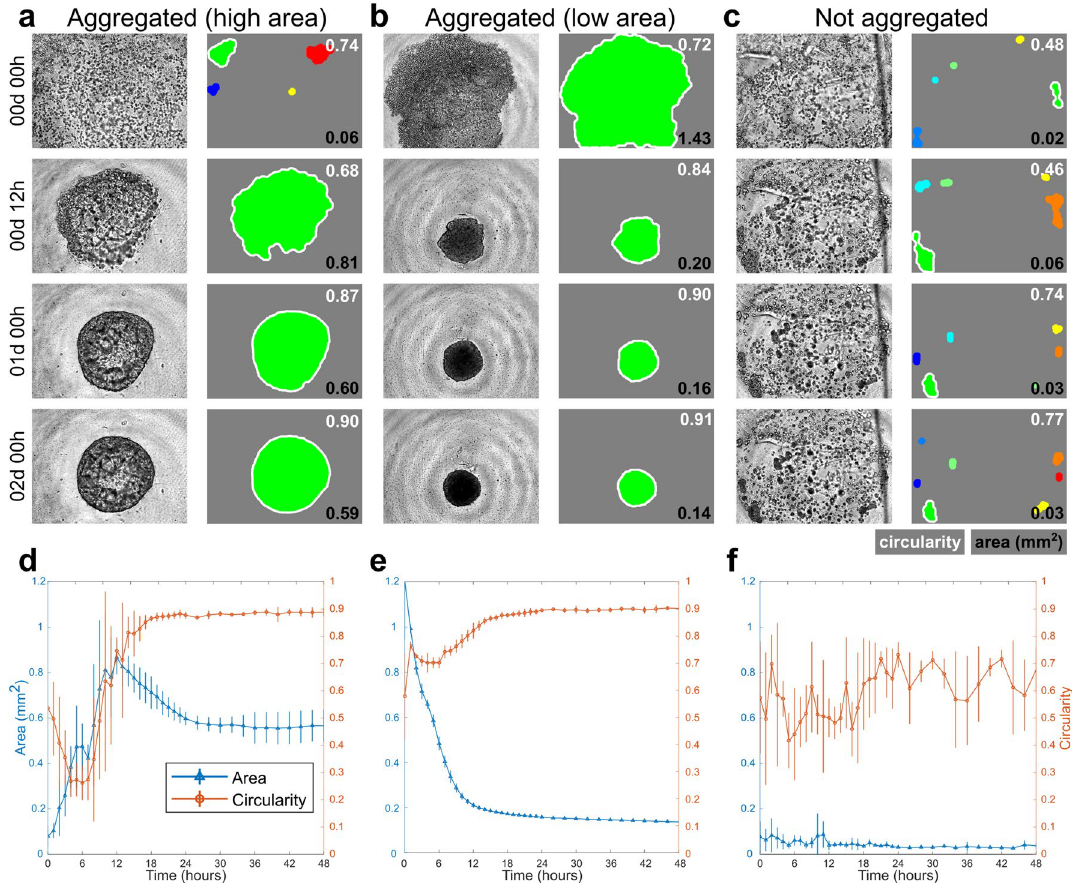
Figure 2. Image analysis comparing aggregated (high area), aggregated (low area), and not aggregated structures within the first 48 h. Original and processed images are shown for representative ( a ) aggregated (high area) (200 μg/mL Matrigel and 100 ng/mL HB-EGF), ( b ) aggregated (low area) (no Matrigel and 100 ng/ mL HB-EGF), and ( c ) not aggregated (200 μg/mL Matrigel and 0.1 ng/mL HB-EGF) structure formation over the first 48 h. Only the green object outlined in white (the largest structure) is quantified. Area and circularity measurements for ( d ) aggregated (high area), ( e ) aggregated (low area), and ( f ) not aggregated structure formation over time are calculated averages from quadruplicate experiments (shown as mean ±